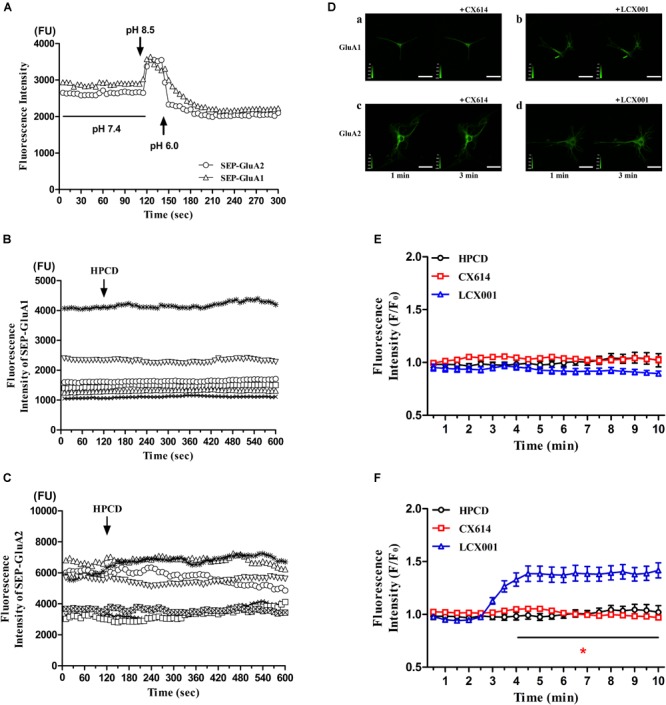
LCX001 increased surface expression of GluA2-containing AMPARs. (A) Time courses of SEP-GluA1 and SEP-GluA2 fluorescence in primary medulla oblongata neurons after exposure to extracellular alkali or acidic solutions. (B,C) SEP-GluA1 or SEP-GluA2 fluorescence time course after vehicle (20% HPCD) treatment at the time point of 2 min. The application of vehicle control had no influence on fluorescence intensity, n = 6. (D) Representative live cell images from primary medulla oblongata neurons transfected with SEP-GluA1 or SEP-GluA2 in the presence of LCX001 or CX614 (final dose of 47 μM). a. SEP-GluA1 treated with CX614 at 2 min, b. SEP-GluA1 treated with LCX001 at 2 min, c. SEP-GluA2 treated with CX614 at 2 min, d. SEP-GluA2 treated with LCX001 at 2 min. (E,F) Relative fluorescence intensity to the vehicle of pHluorin-GluA2 and GluA1 in response to LCX001 or CX614 treatment. Application of LCX001 at a final dose of 47 μM resulted in a significant increase in SEP-GluA2 fluorescence and enhanced stabilization of surface GluA2-containing AMPARs. ∗P < 0.05, two-way ANOVA followed by Bonferroni post-hoc tests, mean ± SEM, n = 6–7.